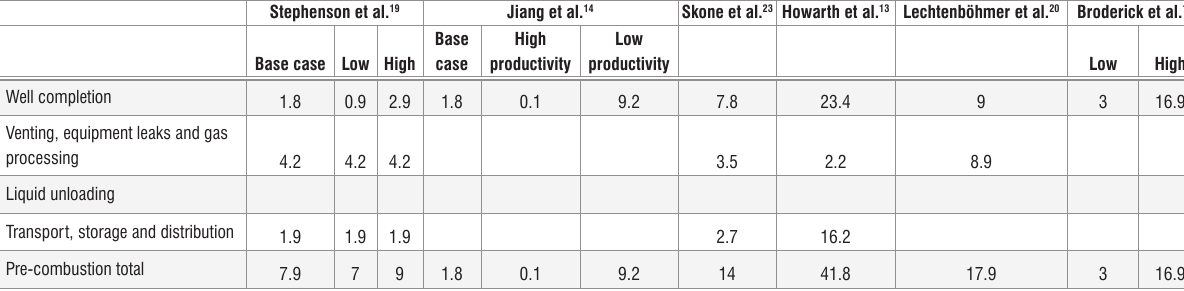
Table 1: Breakdown of pre-production and pre-combustion emissions (g CO